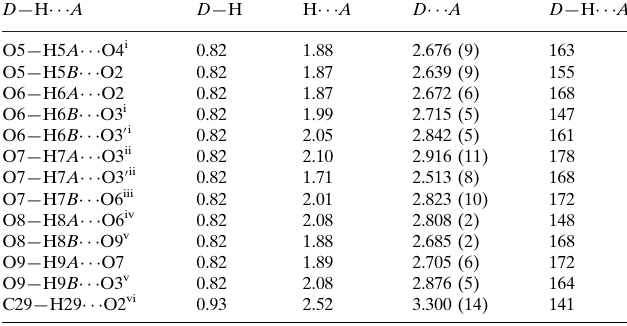
Hydrogen-bond geometry (A˚ , (cid:3) ). D —H (cid:2)(cid:2)(cid:2)